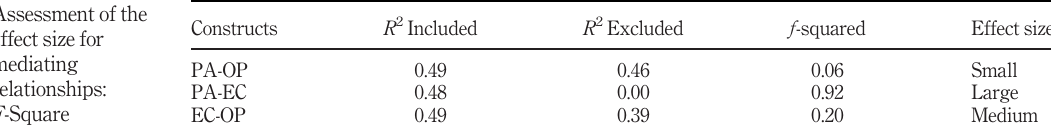
Table VII. Assessment of the effect size for mediating